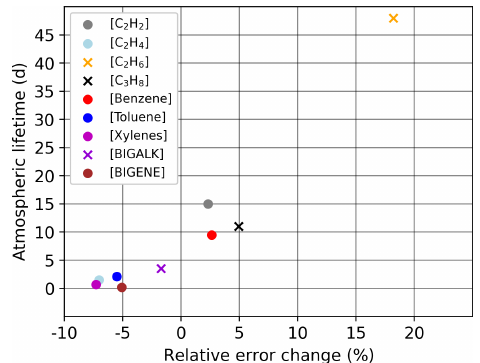
Figure 3. Atmospheric lifetime (from Simpson et al., 2020) in days for the VOCs added to the state vector. Xylenes, BIGALK, and BI- GENES are surrogate species, so an average of the lifetimes is cal- culated. The relative error change is the opposite of the difference in root mean square error relative to the control run (i.e., (control-run- MOPITT-DA) / control run). Thus, a positive relative error change means an improvement compared to the control